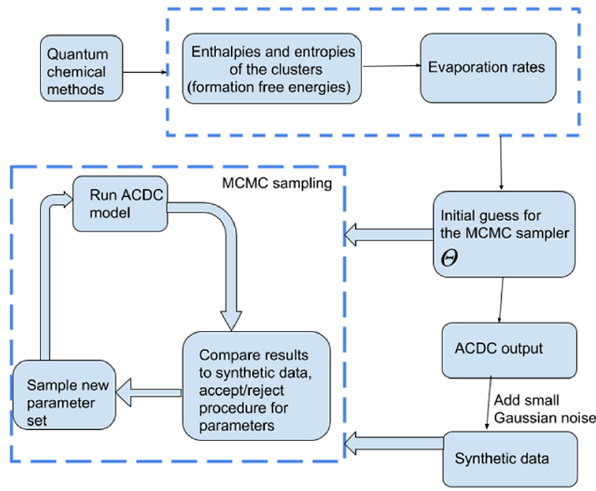
Figure 1. Schematic representation of the study